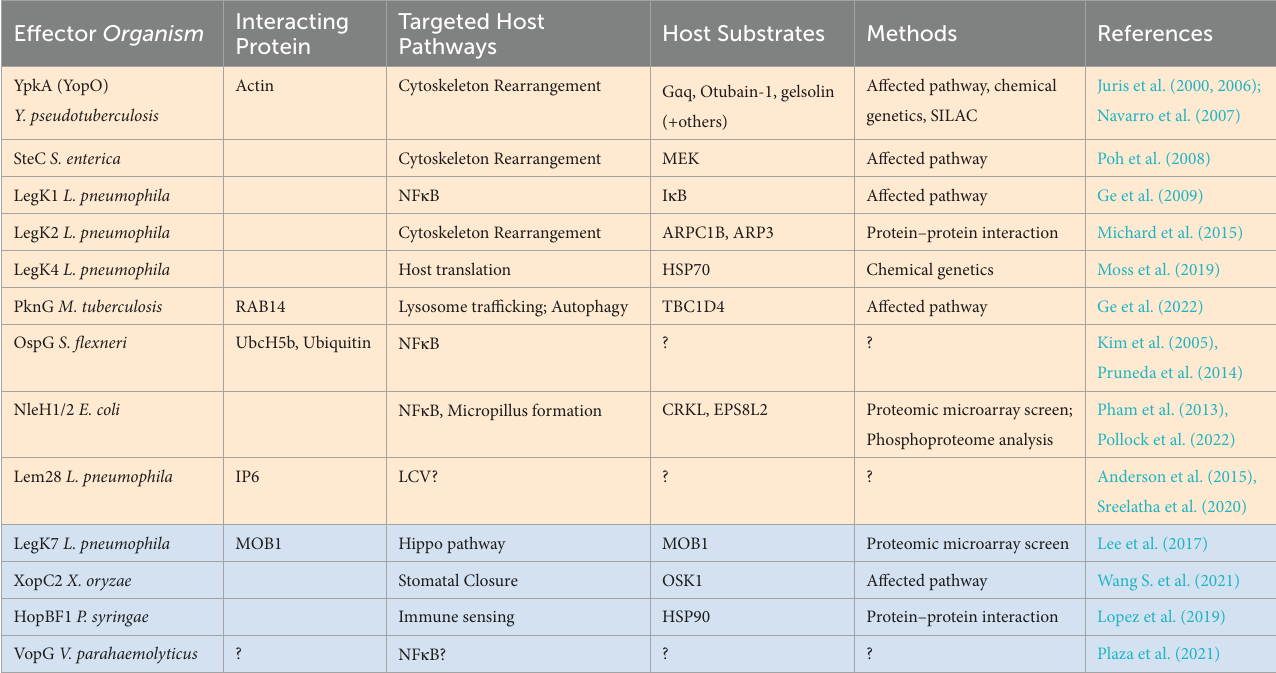
TABLE 1 Bacterial effector kinases, currently identified targeted host pathway, and substrate identification